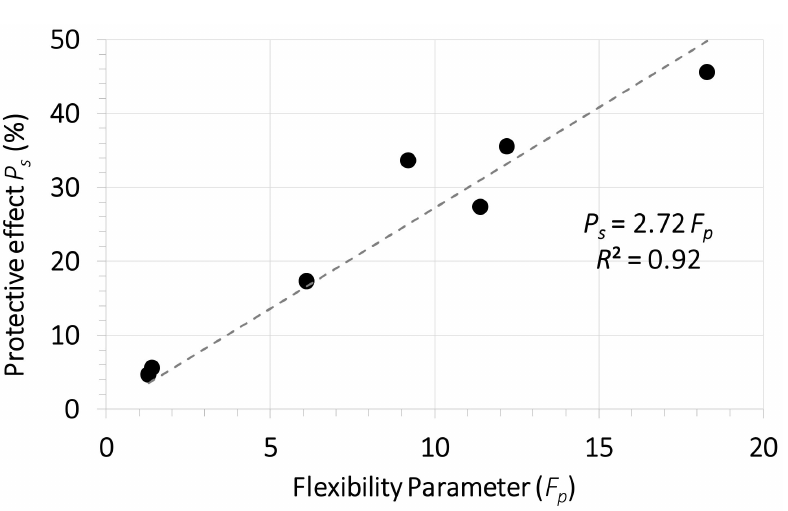
Figure 18. Relationship between protective effect ( P s ) and flexibility parameter ( F p